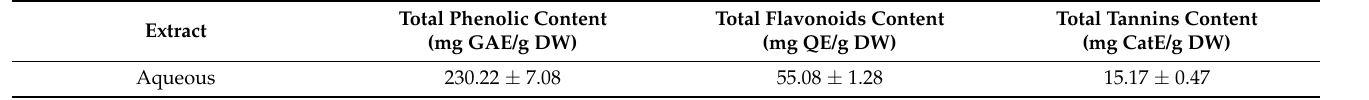
Table 1. Total phenolic, flavonoid and tannins contents of Cleome fruits extract. Total Phenolic Content Extract (mg GAE/g DW)